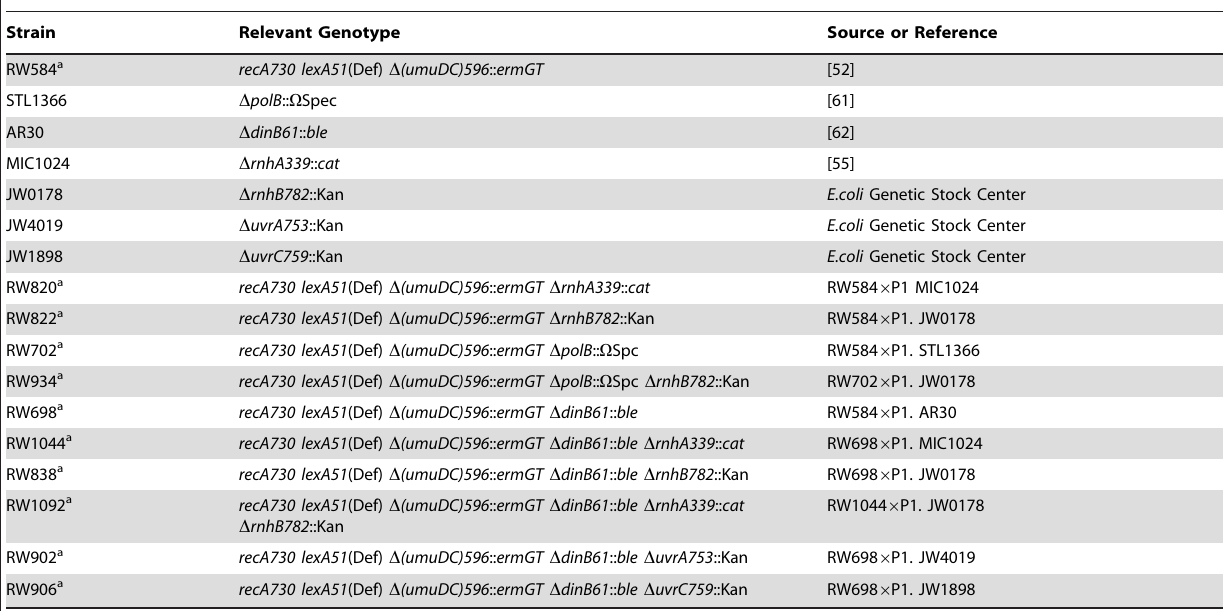
Table 1. E. coli strains used in this